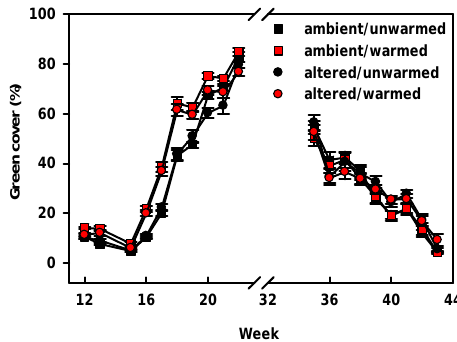
Fig. 4. Cover of green vegetation (%) during spring and fall, by rainfall pattern and warming treatment during 2005–2007. Error bars denote